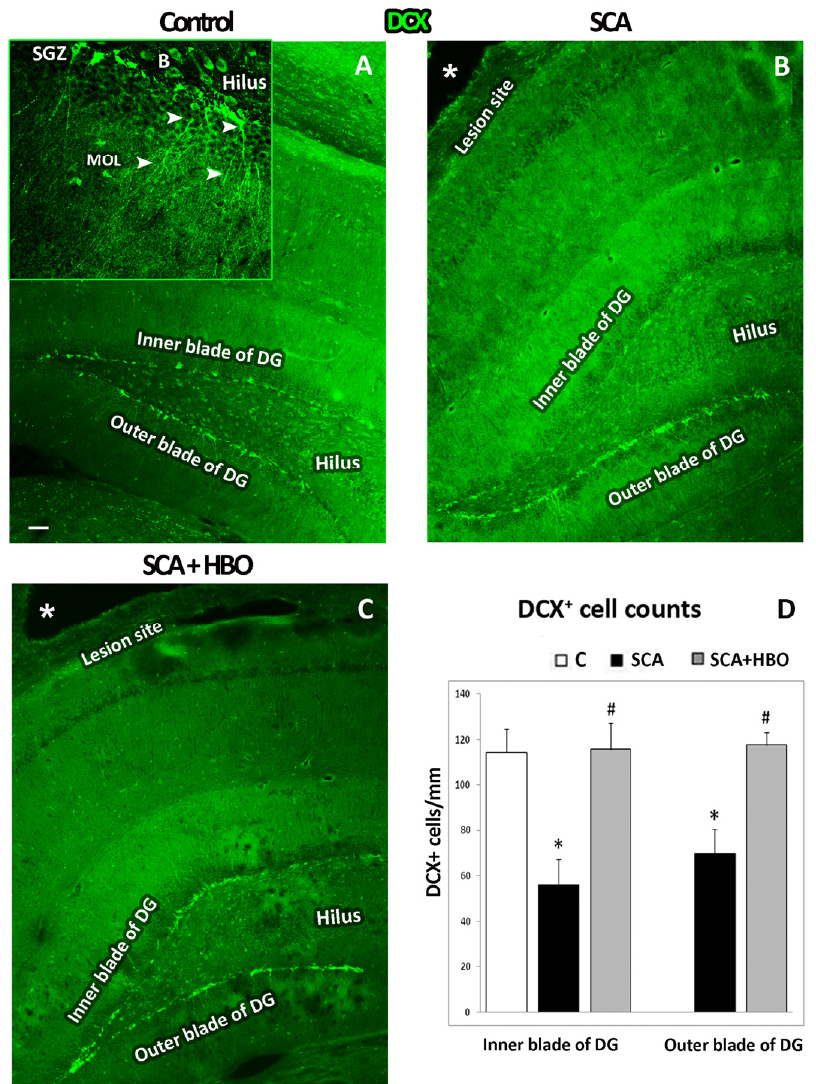
Figure 3. HBOT prevented the loss of doublecortin (DCX)-immunopositive newborn immature neurons after SCA (suction cortical ablation) in the subgranular zone (SGZ) of the hippocampal dentate gyrus (DG). A total of 25 µ m thick frozen brain sections of C—Control, SCA—Suction cortical ablation, and SCA + HBO—SCA animals treated with hyperbaric oxygen were stained with DCX (green). ( A ) In the control sections, intensive DCX-immunopositivity was seen in the SGZ of the inner and outer blades of the DG. At higher magnification (inset), intensively DCX-labeled newborn neurons with branched dendrites (arrowheads) extended from the SGZ until the molecular layer (MOL). In addition, DCX immunoreactivity is detected in progenitors and basket cells ( B ) in the hilus. ( B ) SCA reduced DCX-immunofluorescence and was particularly pronounced in the inner blade of the DG beneath the lesion site (asterisk). ( C ) After 10 successive HBOT (hyperbaric oxygen therapy), the level of DCX-immunopositivity was as observed in the control. ( D ) DCX-positive cells were counted separately in the SGZ of the inner and outer blades of the hippocampal DG. Bars represent mean ± SD. Control (C, white bar), SCA (black bars), and HBO (hyperbaric oxygenation)-treated animals (SCA + HBO, gray bars). The significance level was analyzed using One-way ANOVA with Tukey’s multiple comparisons post hoc test (* p < 0.001 SCA vs. C, # p < 0.001 SCA + HBO vs. C). Scale bar: ( A – C )—100 µ m.